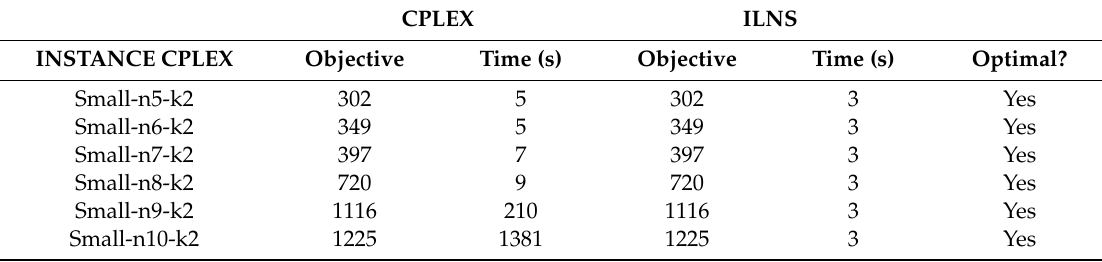
Table1. ComputationalresultsofCPLEXandtheimprovedlargeneighborhoodsearch(ILNS)algorithm. CPLEX ILNS INSTANCE